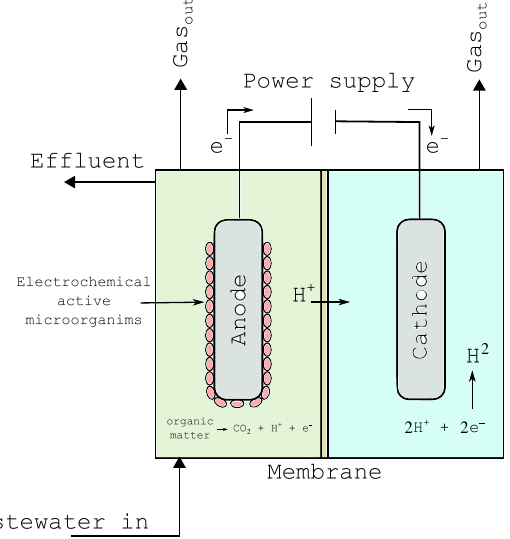
Figure 1. Schematic diagram of the